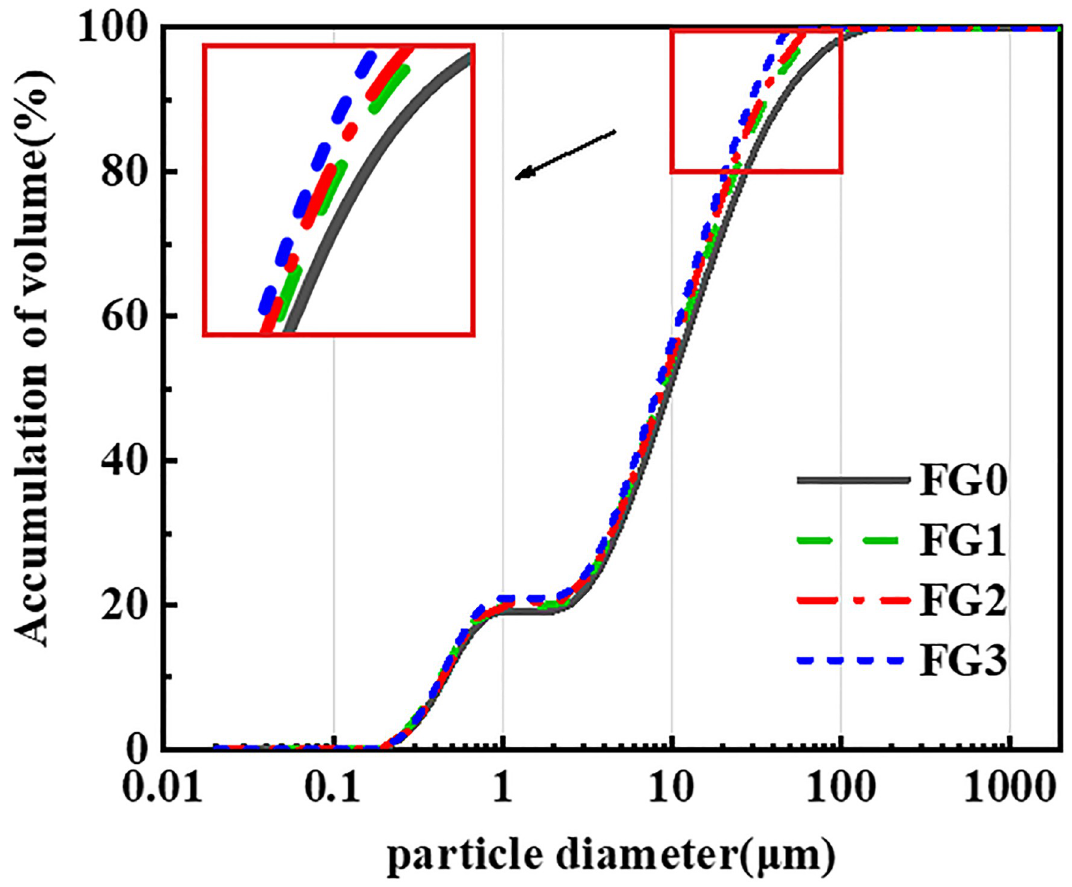
Fig 2. Particle size distribution